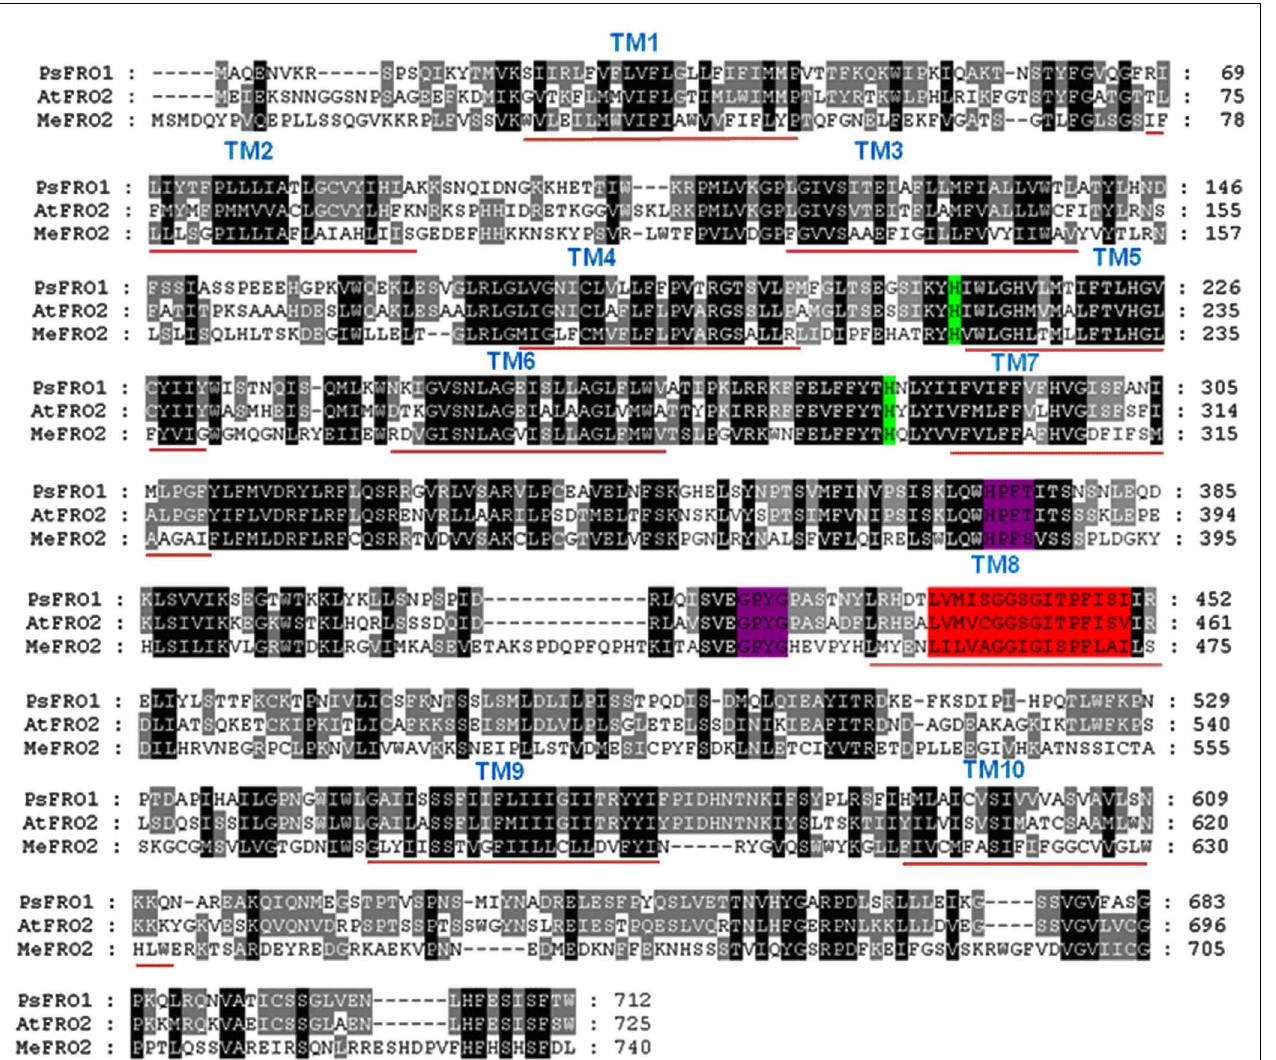
binding are highlighted green, the conserved FAD-binding motif (HPFT) and the NAD-binding motif (GPyG) are highlighted in purple.The oxidoreductase signature sequence are highlighted in red. Species designations are as follows: At, A. thaliana (AtFRO2); Ps, P. sativum (PsFRO1); Me, Mannihot esculenta